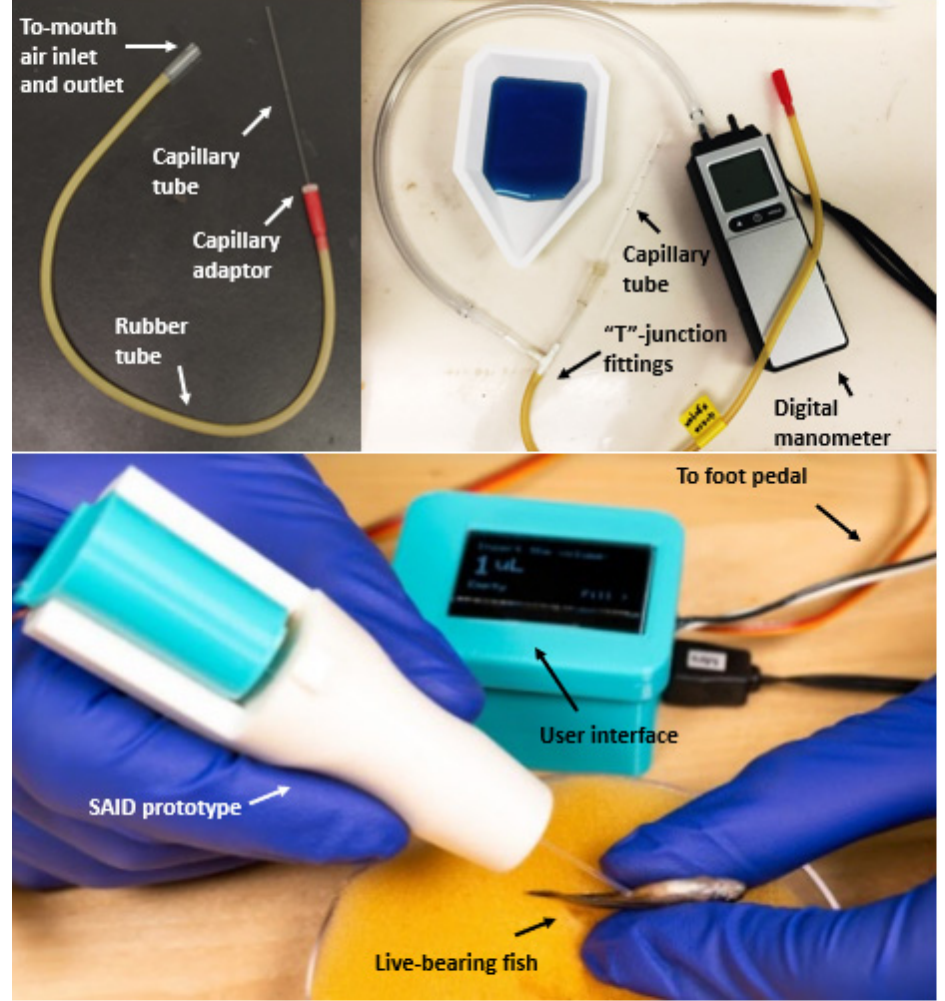
Figure 1. Comparison of the existing mouth-pipetting tool [31] and the standardized artificial insemination device (SAID) for use with small-bodied live-bearing fishes. A standard mouth-pipetting tool (upper left) consists of a capillary that fits into a rubber tube with adaptor fittings. Pressures generated during mouth-pipetting were characterized by use of a digital manometer (upper right) with a “T”-junction fitting. A prototype of the SAID (bottom) is shown during injection of samples into the reproductive tract of a female live-bearing fish.